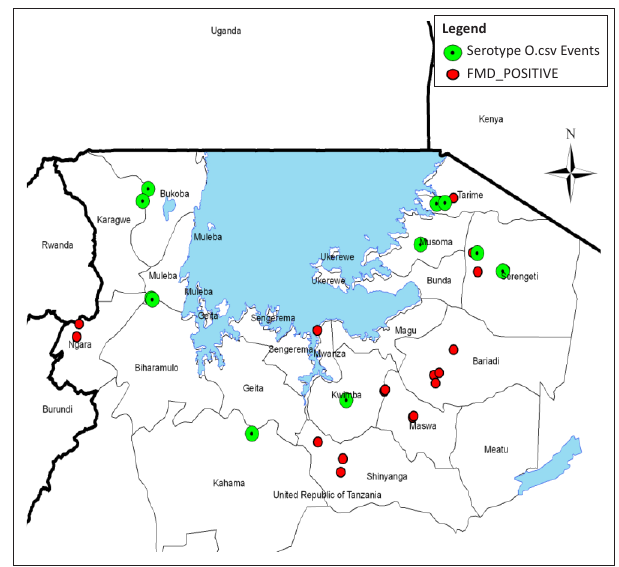
FIGURE 2: Spatial distribution of foot-and-mouth disease and its serotypes in the lake zone of Tanzania.